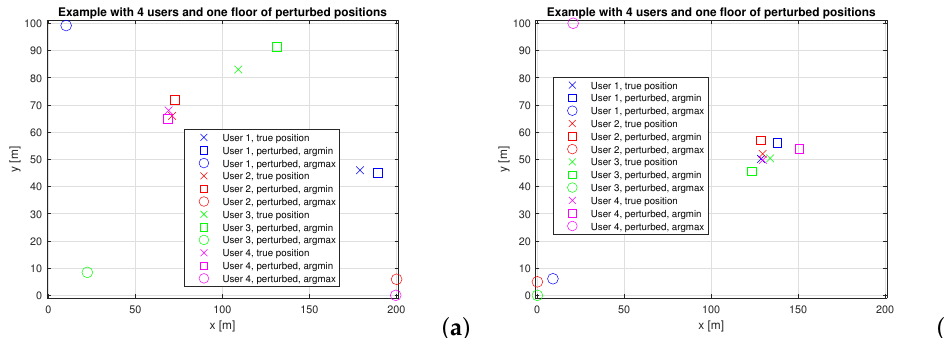
Figure 6. Two examples of perturbed location via argmin + Laplacian noise and via argmax + Laplacian noise. ( a ) users uniformly distributed over one floor; ( b ) users uniformly distributed within a circular hotspot of radius 5